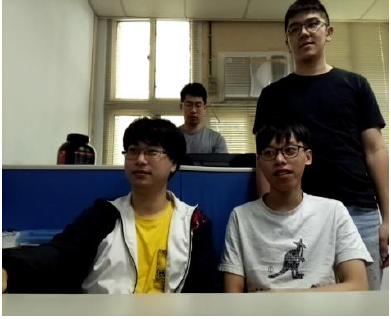
Figure 11. Example of an image that can be captured by the Raspberry Pi camera.